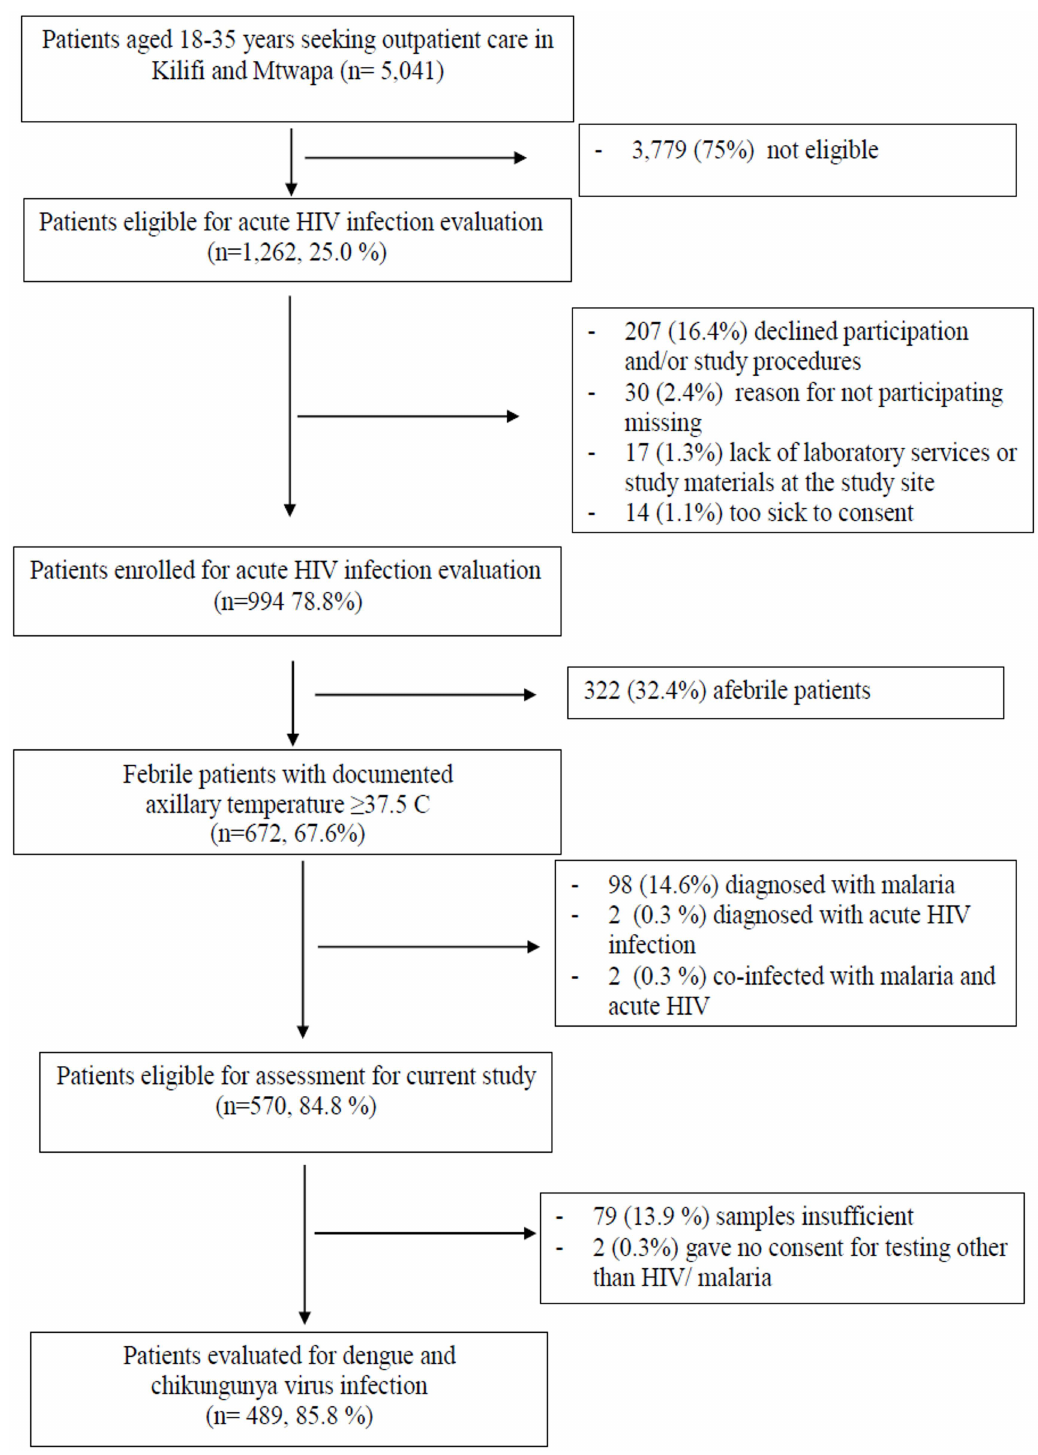
Fig 1. Flow chart of outpatients aged 18–35years screenedfor evaluation at care seeking in Kilifi or Mtwapa, February 2014 –January2015.